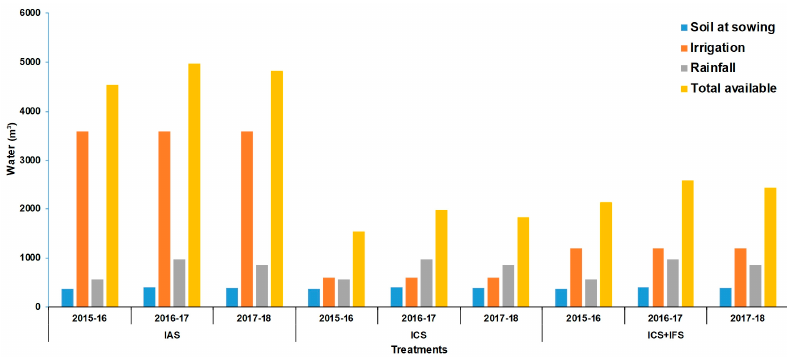
Figure 2. Amount of water (m 3 ) available to the crop during the experimental years.